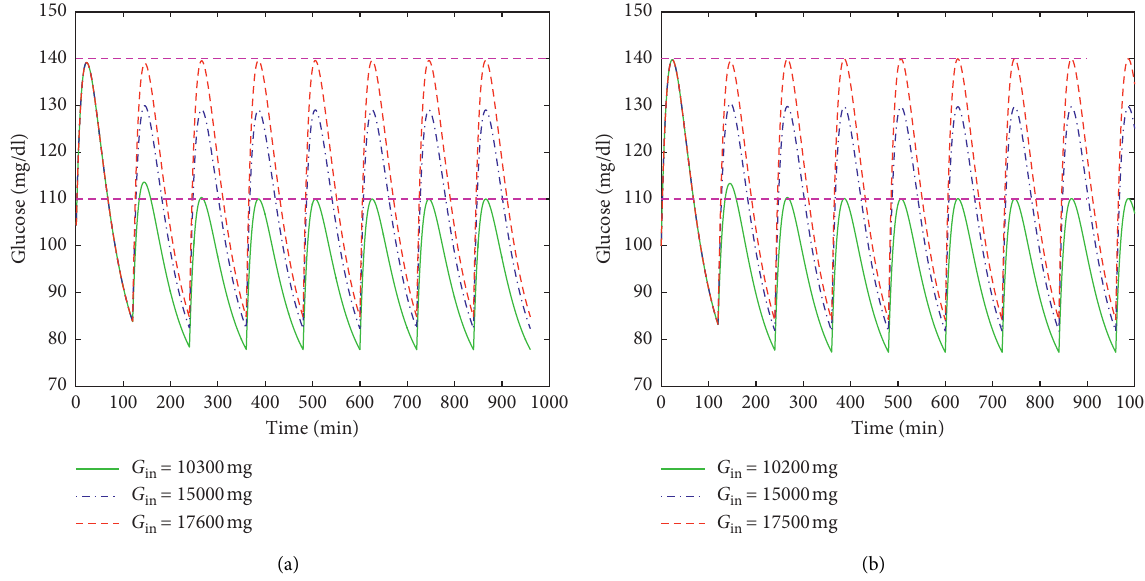
Figure 7: Range of glucose intake amount for maintaining normal glucose level when τ � 120min: (a) range of glucose intake amount of system (5) and (b) range of glucose intake amount of system